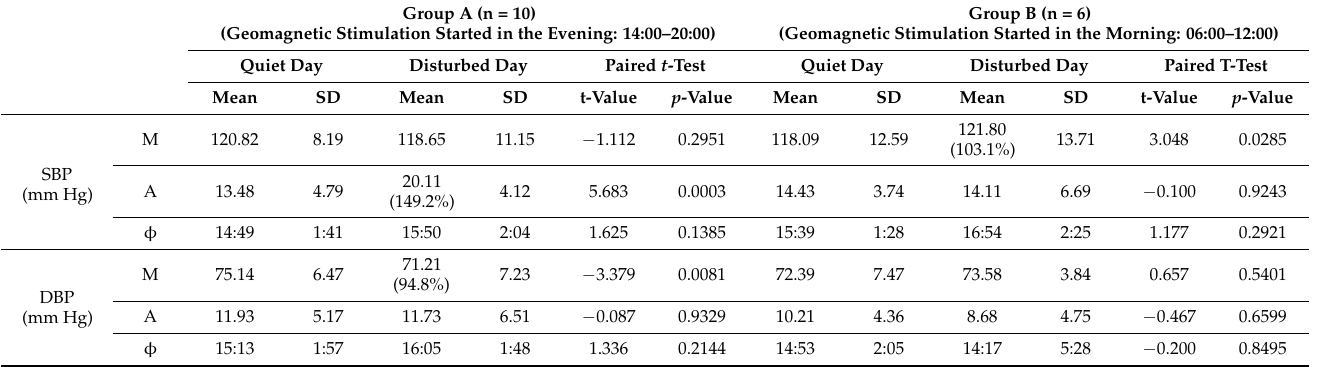
Figure 4. Response of the circadian amplitude of SBP ( left ) and HR ( right ) to geomagnetic stimulation starting either in the evening ( left ) or in the morning ( right ). Chronomodulatory effects of geomagnetic stimulation on the circadian amplitude of SBP (left) and HR ( right ) exist in clinically healthy individuals. When geomagnetic disturbances start in the evening, the circadian amplitude of SBP is increased ( p = 0.0003, Table 4 left); when they start in the morning, the circadian amplitude of HR is increased ( p = 0.0596, Table 4 right). Table 4. Changes in BP and HR characteristics depend on the circadian phase at which geomagnetic stimulation